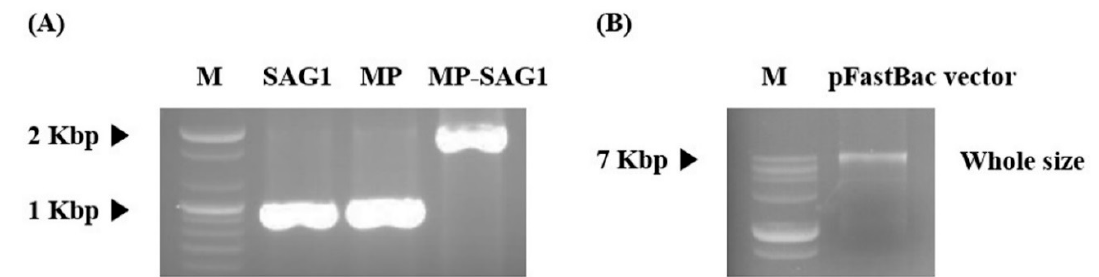
Figure 2 . The analysis of specific genes on VLPs containing T. gondii surface antigen 1 (SAG1) and influenza matrix genes. ( A ) T. gondii SAG1 gene (1011 bp), influenza A matrix protein 1 gene (MP; 1027 bp), and SAG1-matrix protein 1 gene (2038 bp) cloned into the pFastBac vector. ( B ) The pFastBac vector containing T. gondii SAG1 and matrix protein 1 genes (whole size; 6813 bp). M: marker; MP: matrix protein 1 gene; MP-SAG1: influenza A matrix protein 1 and SAG1 genes cloned into the vector.